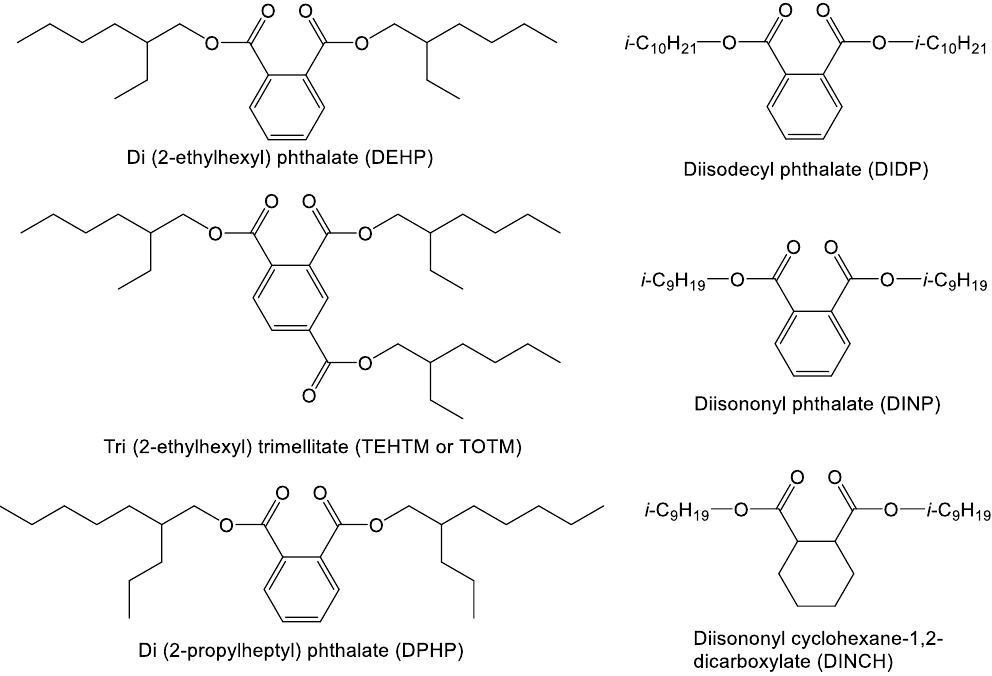
Figure 3. Chemical structures of four commercial phthalate plasticizers and two structurally similar compounds [39].